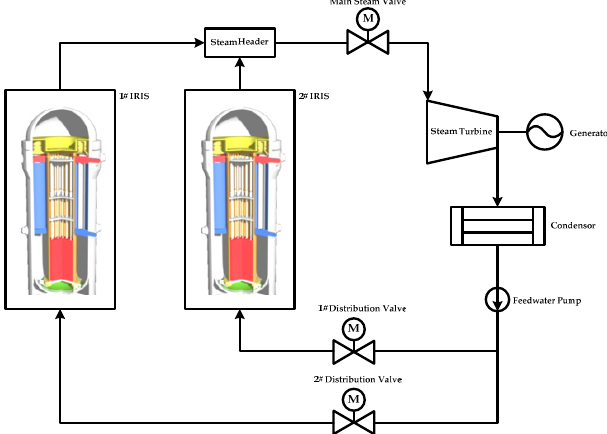
Figure 2. Schematic diagram of a two-modular international reactor innovative and secure (IRIS)-based plant.